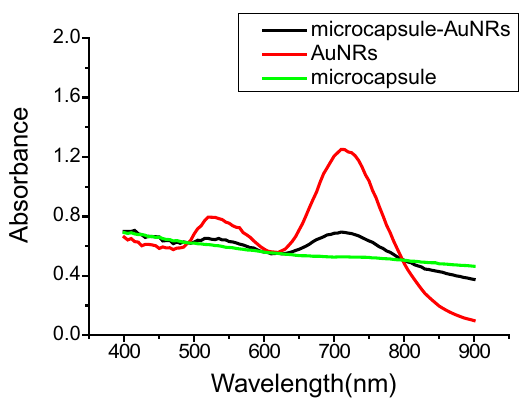
Fig. 3. UV-vis spectra of AuNR-HM microcapsule, AuNRs and microcapsule.